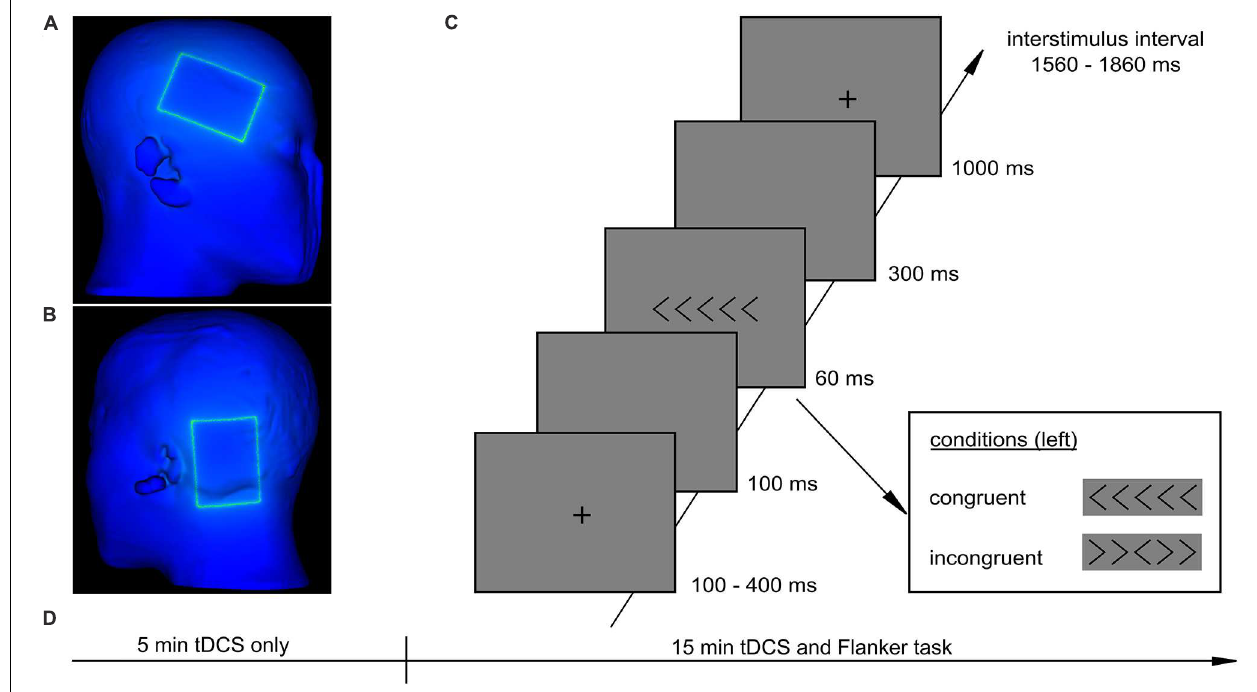
FIGURE 1 | Experimental procedure and task. (A) position of the stimulation electrode, (B) position of the reference electrode, (C) Flanker task, (D) procedure of an experimental session.